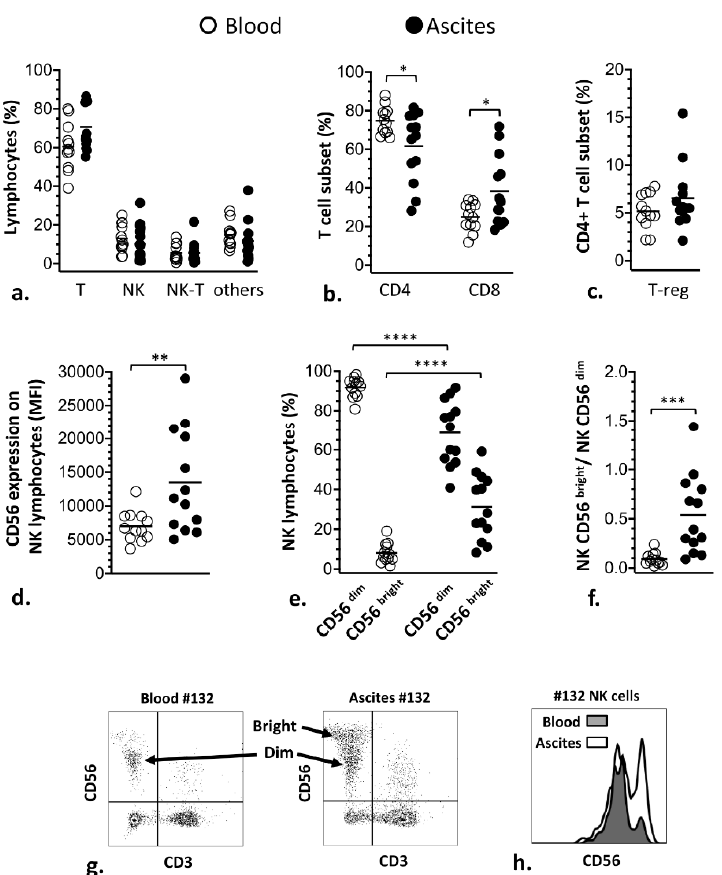
Figure 1. Comparison of the contents of lymphocyte subsets in blood (white circles) and ascites (black circles) from women with advanced EOC. ( a ) Frequencies of T, NK, NK-T lymphocytes; “others” include lymphocytes that were negative for the markers used in cytometry, which mostly comprises B-lymphocytes. ( b ) Frequencies of CD4 and CD8 T-subsets. ( c ) Frequencies of T-reg subset. ( d ) Mean fluorescence intensity (MFI) of the CD56 molecule on NK lymphocytes. ( e ) Frequencies of CD56 dim and CD56 bright subsets of NK lymphocytes. ( f ) Ratio of CD56 bright /CD56 dim . ( g ) Representative dot plots and histogram ( h ) comparing CD56 fluorescence intensity in NK cells from blood and ascites of women with advanced EOC. Statistical analyses were performed by unpaired two-tailed Student’s t -test, and p -values (* p < 0.05, ** p < 0.01, *** p < 0.001 and **** p < 0.0001) indicate significant statistical